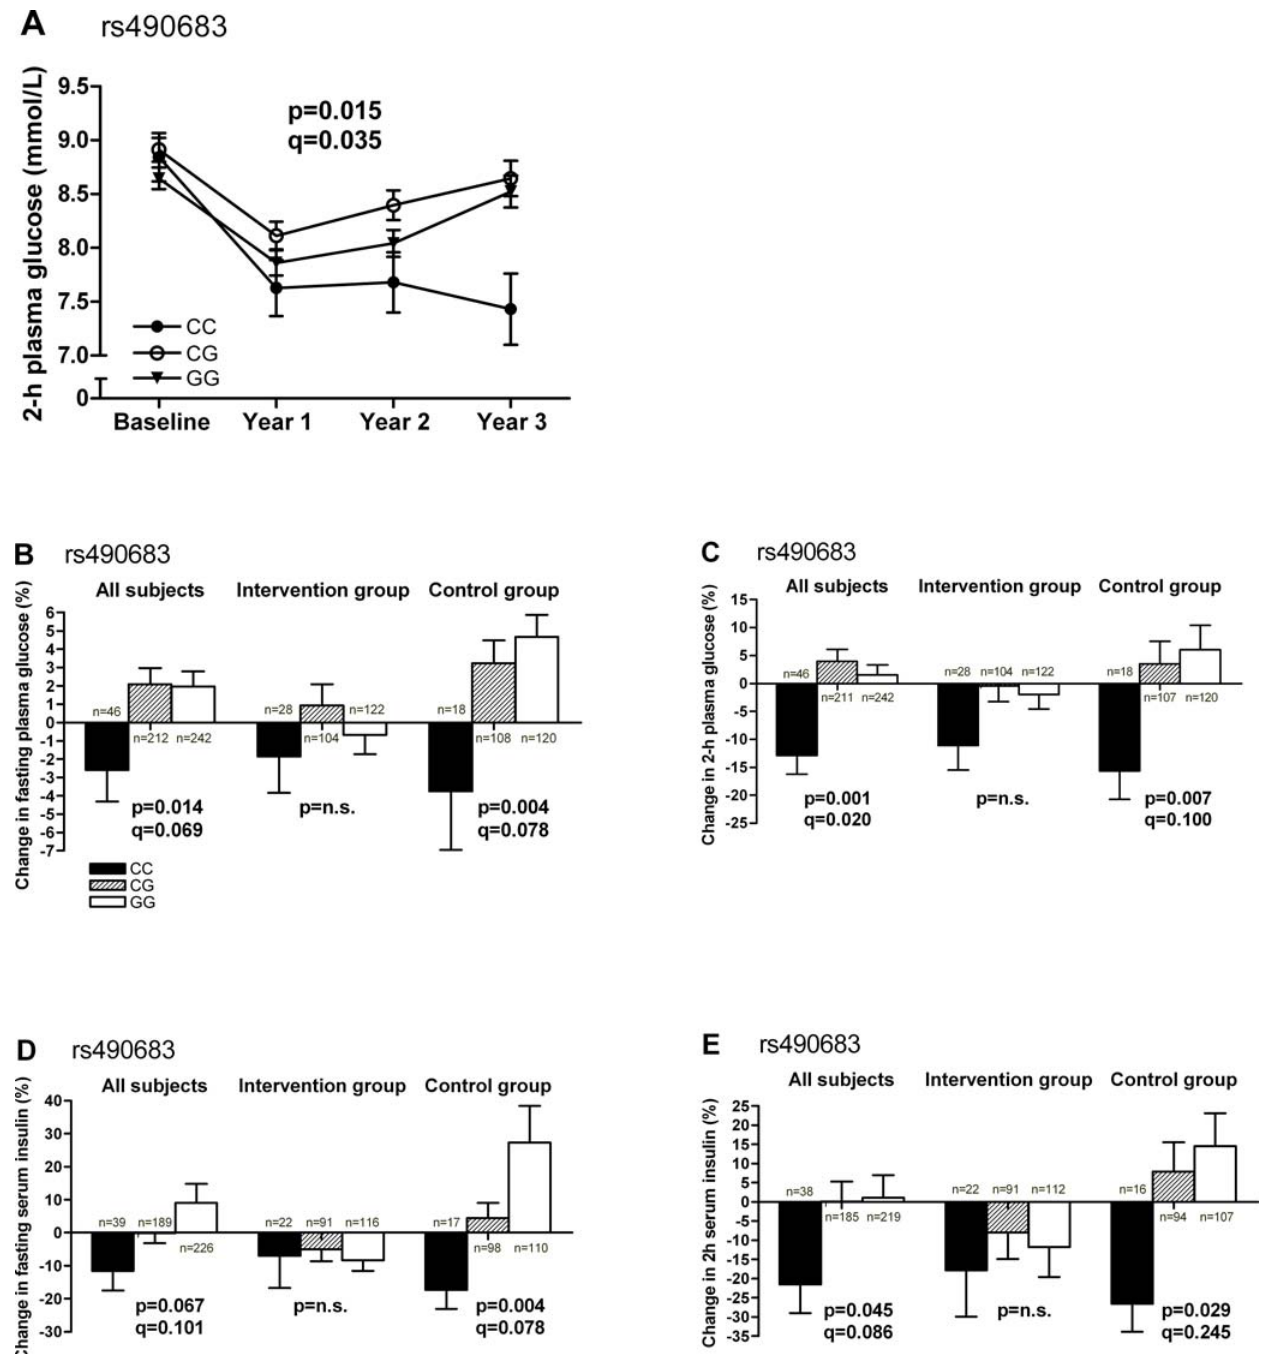
Figure 3. Glucose metabolism measures according to rs490683 genotypes in DPS. A. 2-h plasma glucose according to rs490683 genotypes in all subjects. Mean 6 SEM are estimated marginal means calculated from repeated measures ANOVA with group, age and BMI at baseline as significant covariates. rs490683-CC (n=42, filled circles); rs490683-CG (n=171, open circles); rs490683-GG (n=210, filled triangles). Pair-wise comparisons all subjects: CC vs. CG p=0.020, CC vs. GG p=0.295, CG vs. GG p=0.190. B–E. Relative changes fasting plasma glucose (B), 2-h plasma glucose (C), fasting serum insulin (D) and 2-h serum insulin (E) according to the different genotypes of rs490683 in all subjects and separately in intervention and control group. rs490683-CC (black bars); rs490683-CG (striped bars); rs490683-GG (white bars). The q-value denotes the false discovery rate (FDR) and is reported only for p , 0.1. n.s., non-significant.